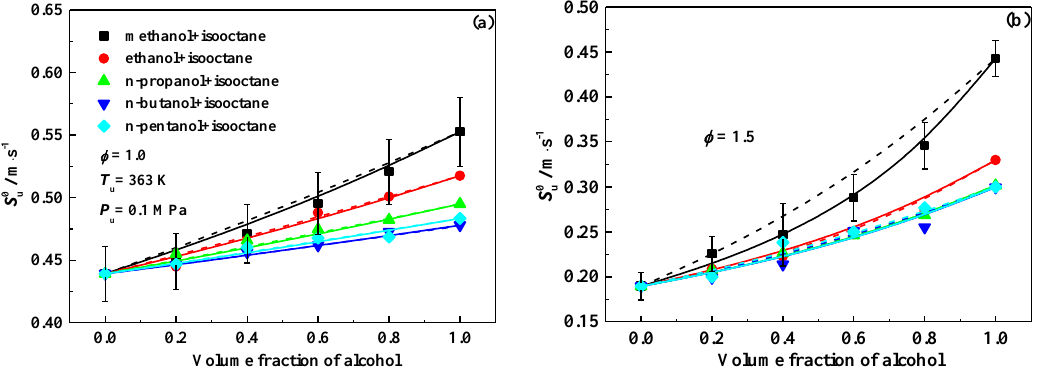
Figure 13. Experimental measurements and calculations at the equivalence ratios of 1.0 and 1.5 for C1–C5 primary alcohol-isooctane blends: ( a ) ϕ = 1.0; and ( b ) ϕ = 1.5. Symbols: experimental data; solid lines: calculations of Equation (8); dash lines: calculations of Equation (9).